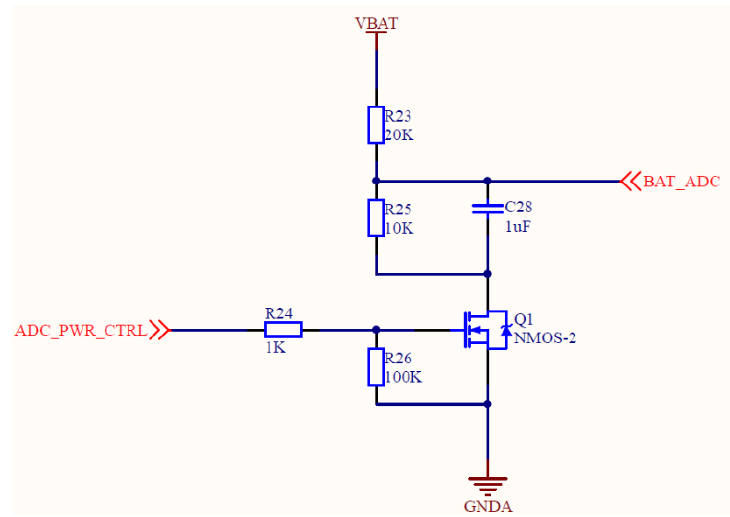
Figure 6. The circuit diagram of battery voltage acquisition circuit.